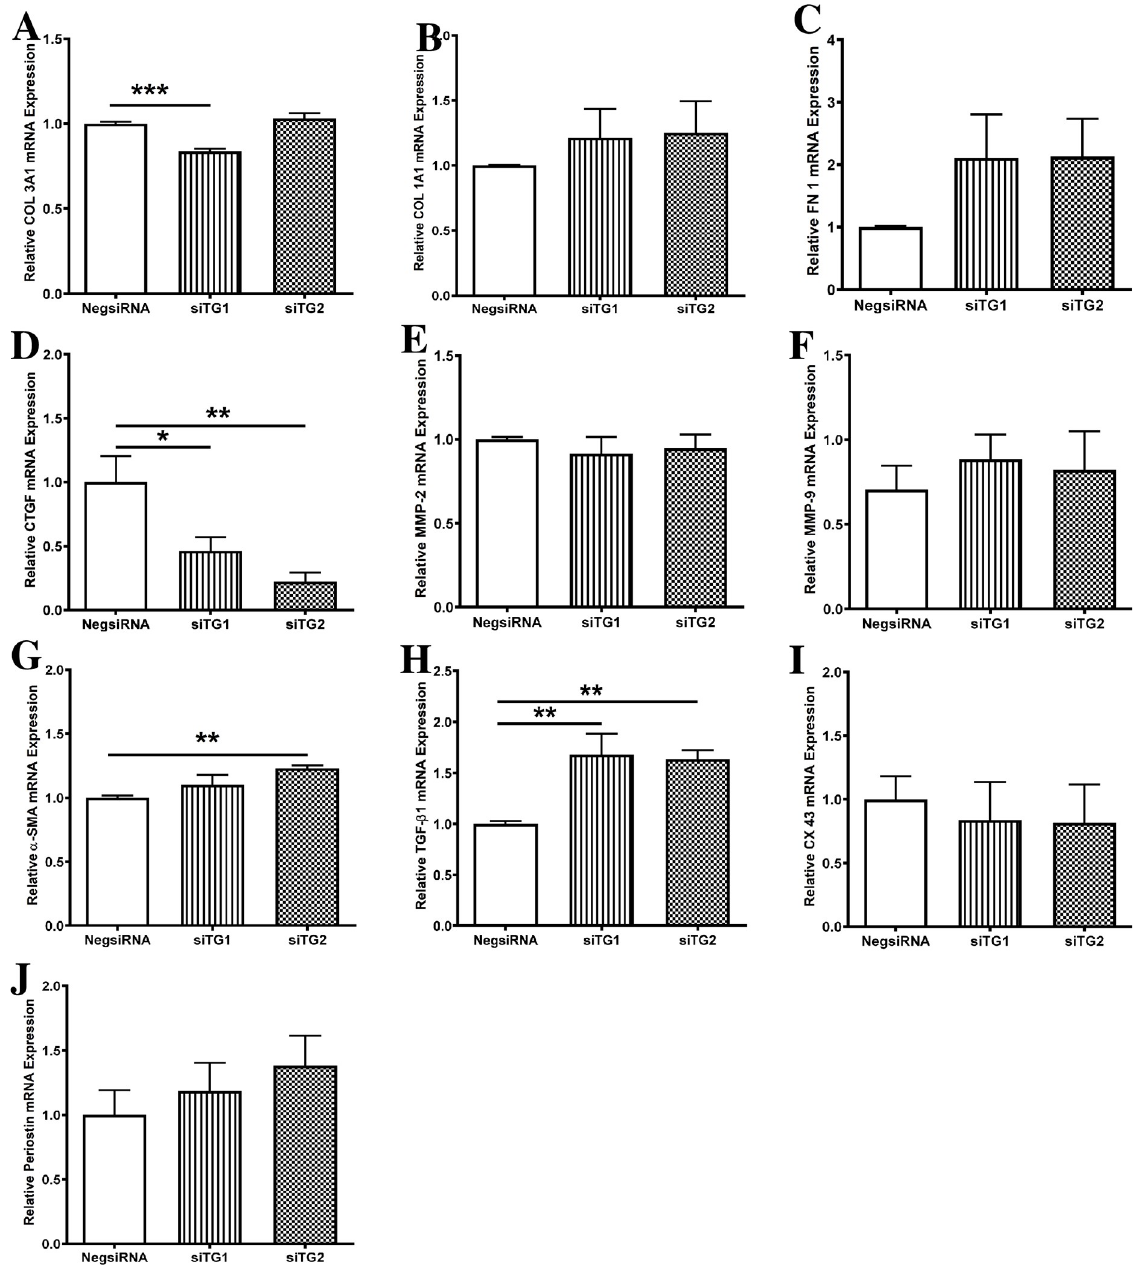
Fig 3. Knockdown of transglutaminase 1 (TG1) and TG2 modified the mRNA expression of several profibrotic markers in neonatal rat ventricular fibroblasts. Effect of transfection of ventricular fibroblasts with siTG1 or siTG2 (n = 4 replicates) on the relative mRNA expression of (A) collagen 3A1 (COL3 A1), (B) COL 1A1, (C) fibronectin 1 (FN 1), (D) connective tissue growth factor (CTGF), (E) matrix metalloproteinase-2 (MMP-2), (F) MMP-9, (G) α -smooth muscle actin ( α -SMA), (H) transforming growth factor β 1 (TGF- β 1), (I) Connexin 43 (CX 43), and (J) periostin. mRNA abundance of profibrotic markers was normalized to that of β 2 microglobulin. Results are means ± SEM; one-way ANOVA followed by Dunnett’s multiple comparison test was performed. � P < 0.05 vs. Negative control (NegsiRNA); �� P < 0.01 vs. NegsiRNA; ��� P < 0.001 vs.